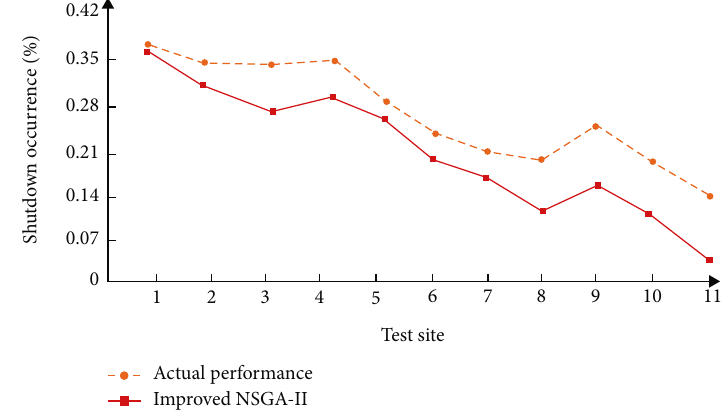
Figure 10: The performance of the aviation material optimization scheduling model in practical scheduling model are better than the actual processing tasks and conducts simulation tests through the improved results of the events in all events, which shows that the MSGA-II algorithm. The results are shown in Figure 10. model has better scheduling ability than the current avia- Figure 10 tests the optimal scheduling model of aviation tion material scheduling model, and this advantage is rel- materials based on the adaptive genetic algorithm with the atively stable. The aircraft material optimization probability of occurrence of downtime of aircraft mainte- scheduling model based on adaptive genetic algorithm nance work as the measurement index. In addition, the anal- has a minimum occurrence rate of downtime accidents ysis is carried out using the occurrence of actual downtime of 0.06%, while the actual occurrence probability in the incidents in the corresponding event as a comparison. The same event is 0.14%. simulation results of the aviation material optimization